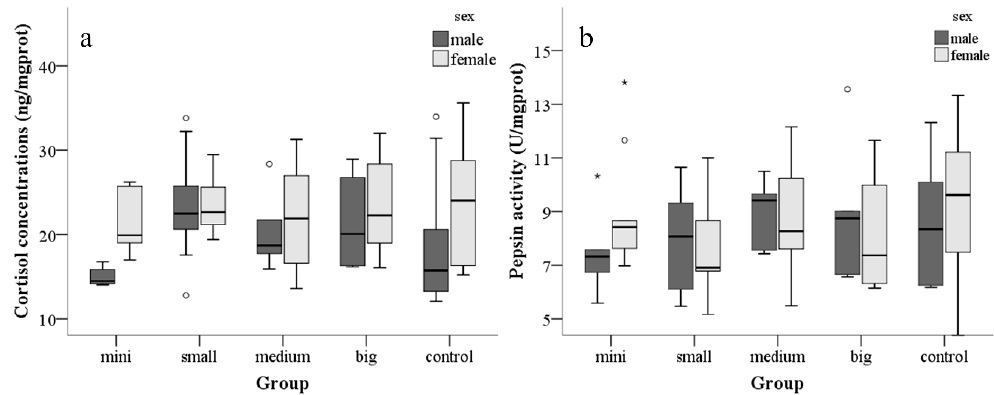
Figure 3. Average physiology test results for each group of males and females. Abscissa: mini tank, small tank, medium tank, large tank, control group. Ordinate: ( a ) cortisol concentrations, ( b ) pepsin activity. ◦ : outlier points. *: extreme points.